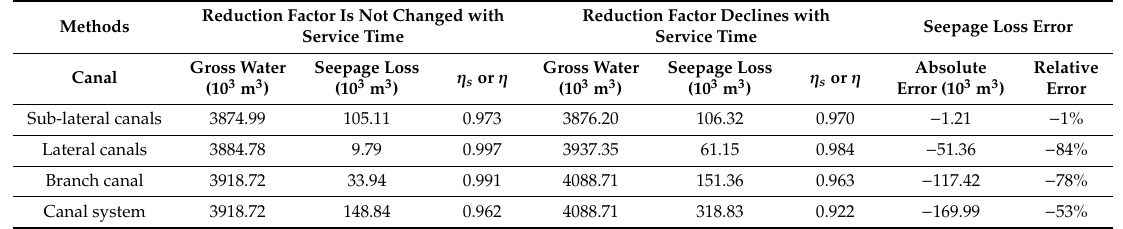
Table 5. Result of canal seepage loss and water e ffi ciency of canal